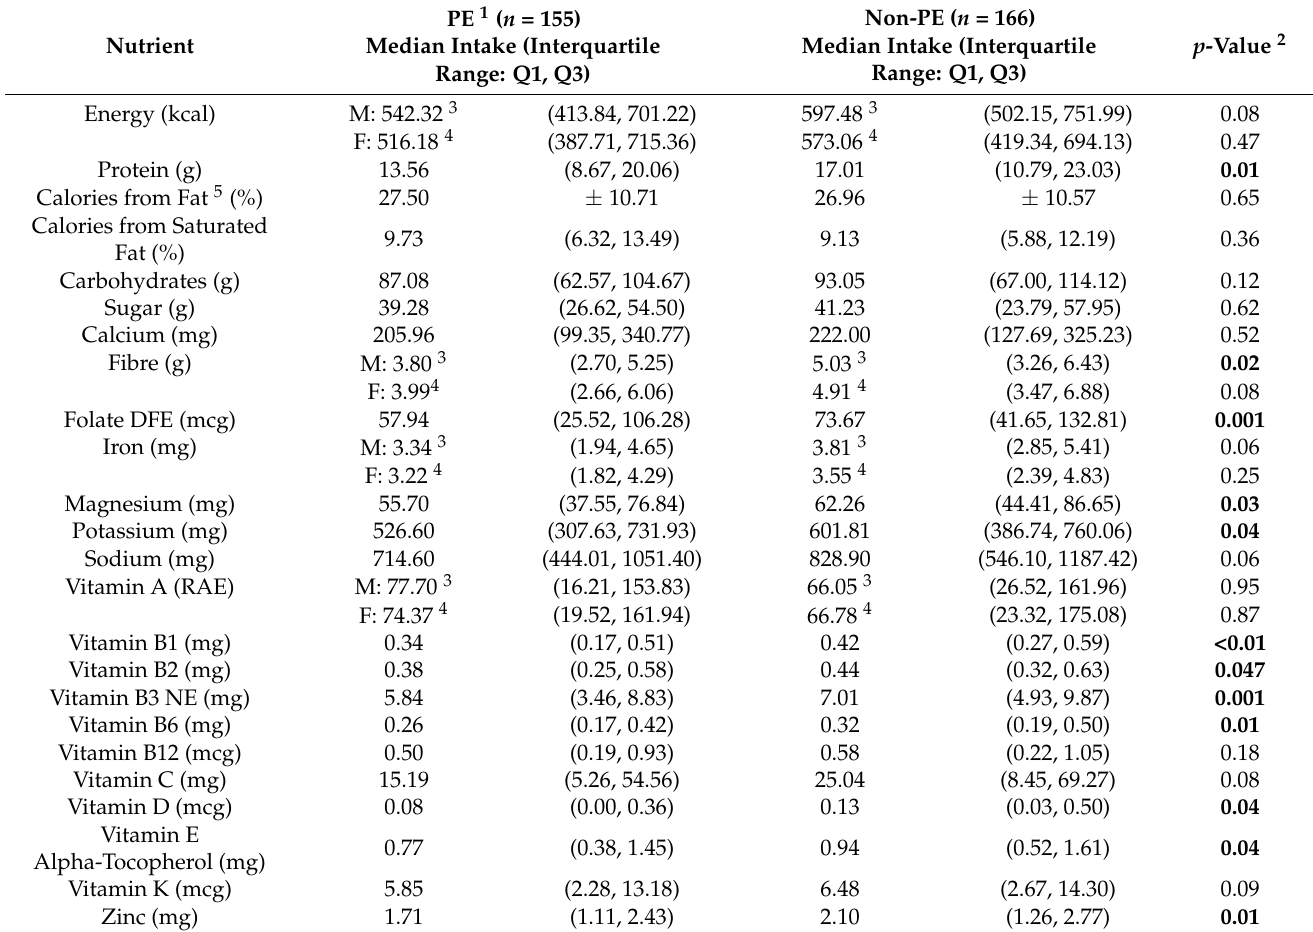
Table 2. Nutrients consumed from home-packed school lunches by picky eating